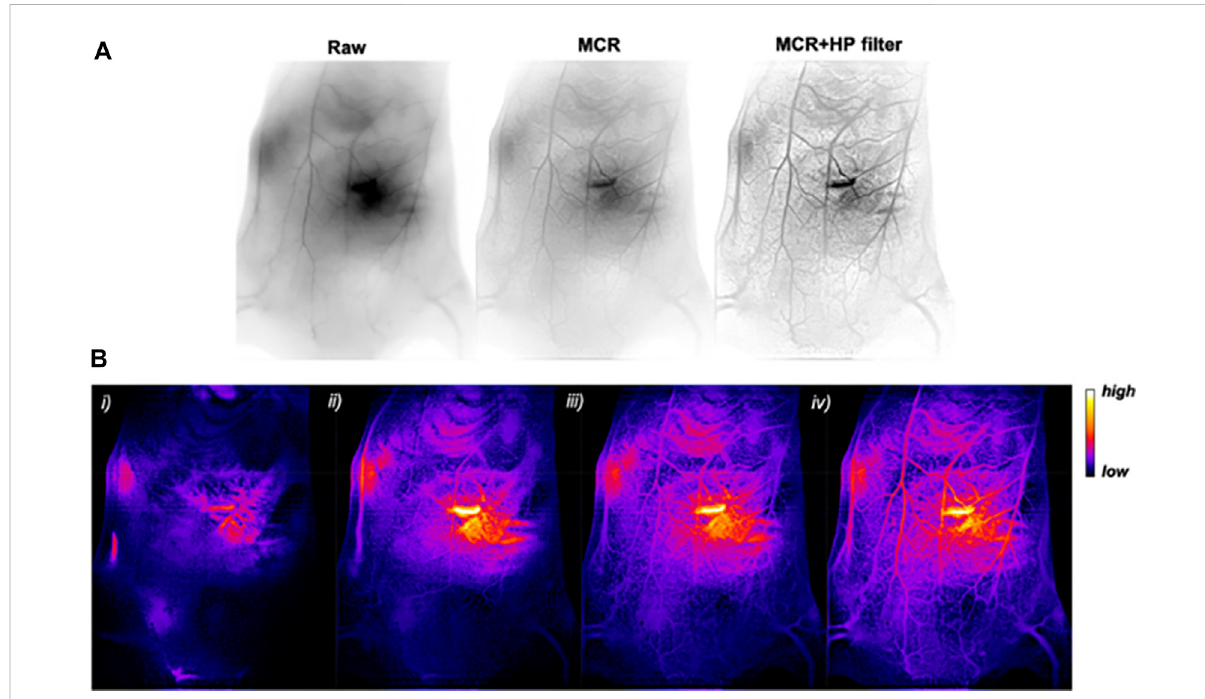
FIGURE 4 (A) In vivo SWIR imaging (reverse contrast) of WT 129/Ola mouse vasculature before imaging processing (raw) and after MC restoration (MCR) and an additional fi ltering (MCR + HP fi lter). (B) MCR + HP fi lter-treated SWIR images (false colors) (i) 1.5 s, (ii) 5 s, (iii) 25 s, and (iv) 65 s